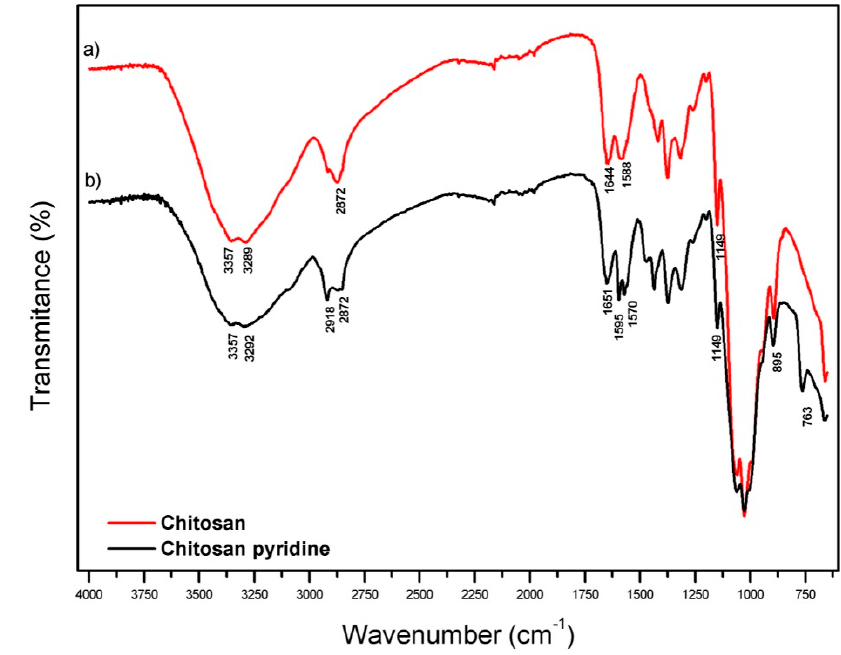
Figure 1. Comparison of the FTIR spectrum of (a) chitosan and (b) Cs-Py . To continue the cellulose functionalization, we cross-linked Com-2 with chitosan or Cs-Py using DMSO as solvent at reflux temperature generating the derivatives Com-3 and Com-4, respec-tively (Scheme 2).